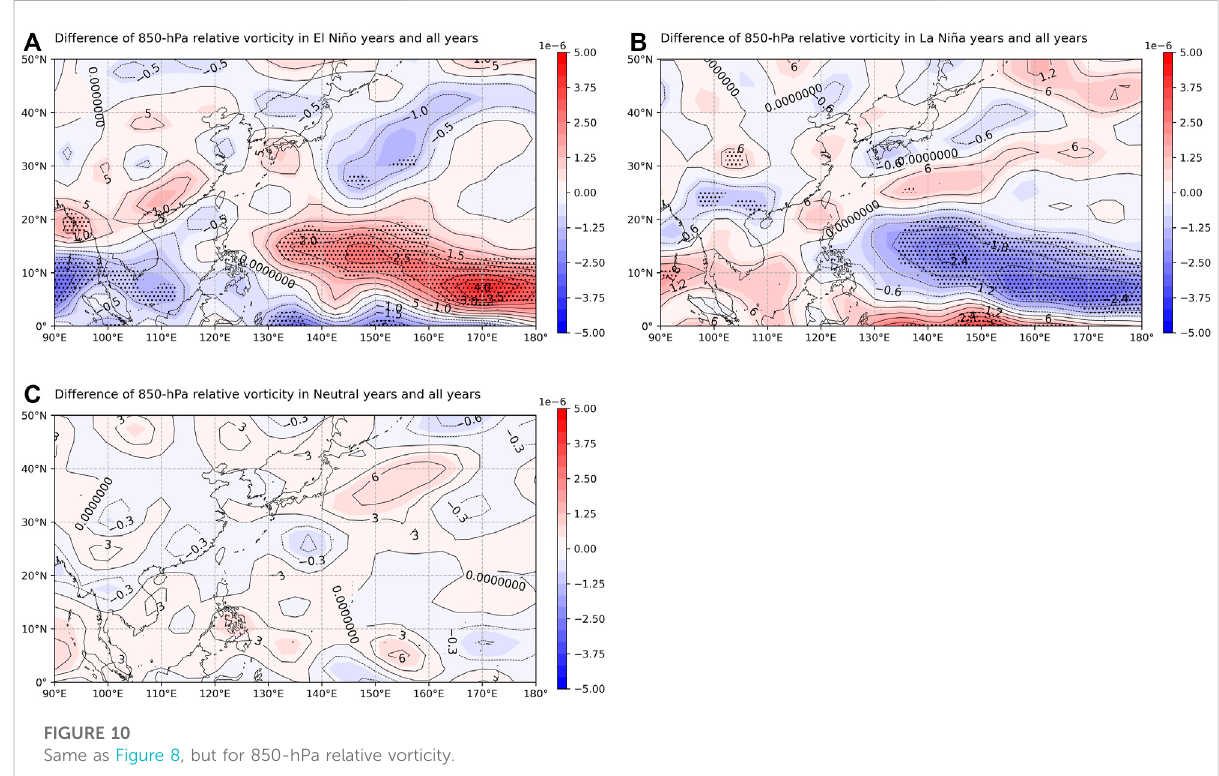
FIGURE 10 Same as Figure 8, but for 850-hPa relative vorticity.